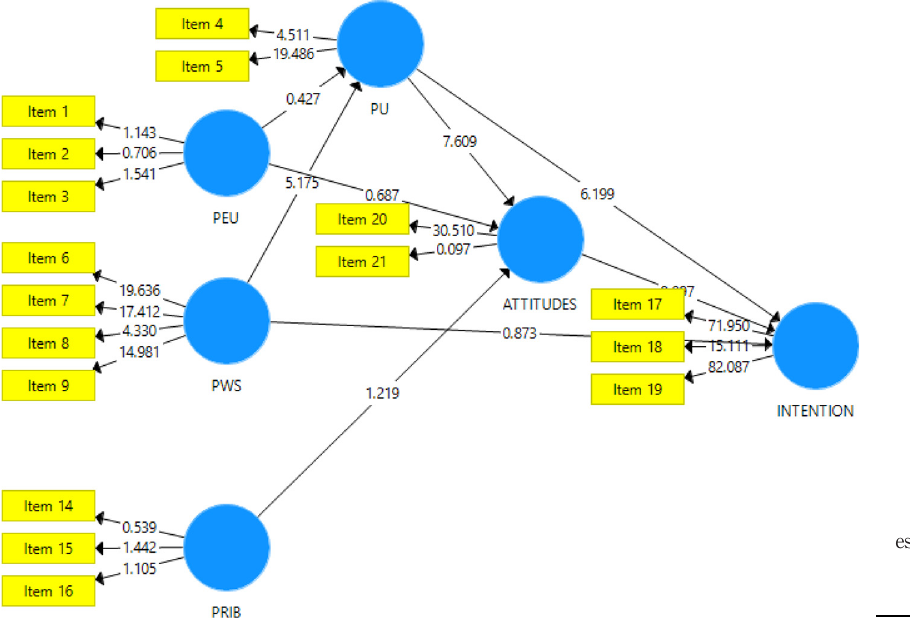
Figure 8. Diagram of